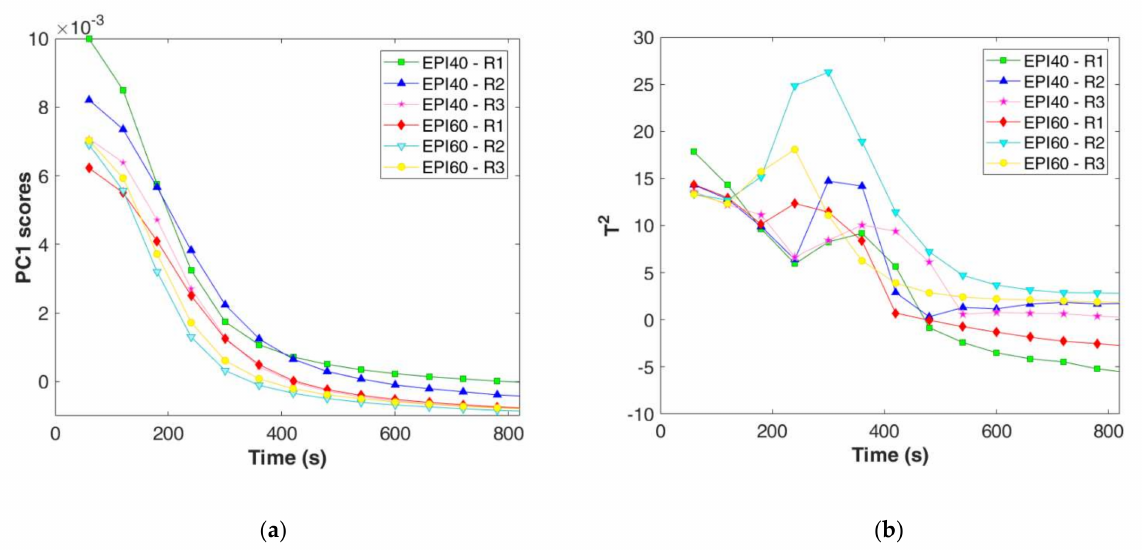
Figure 4. Multivariate statistical process control chart for the calibration dataset: ( a ) zoom on PC1– MSPC chart in the first 800 s; ( b ) zoom on T 2 –MSPC chart in the first 800